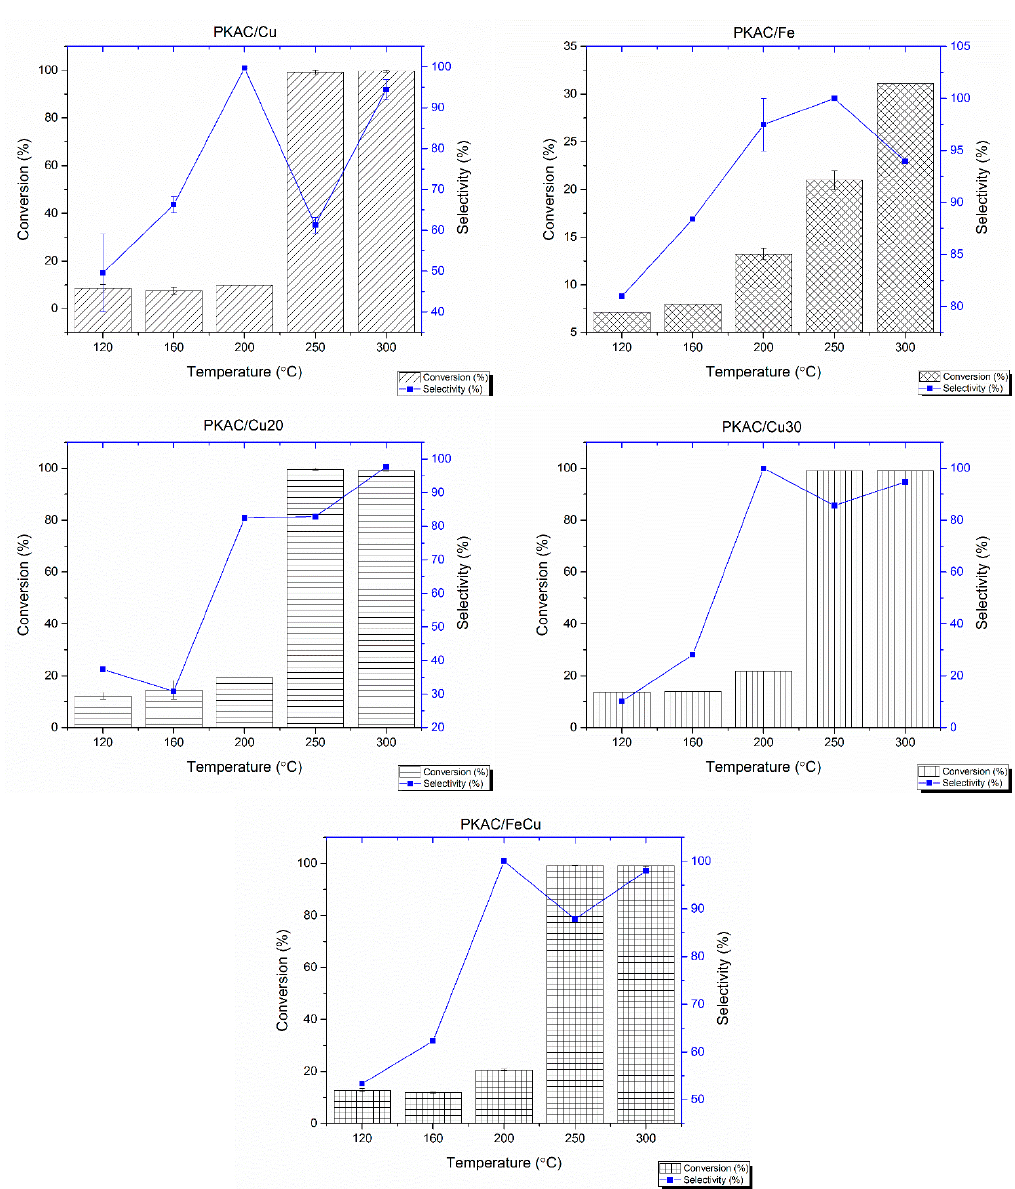
Figure 8. Catalytic activity (NO x conversion and N 2 selectivity) for the monometallic and bimetallic oxide catalysts.